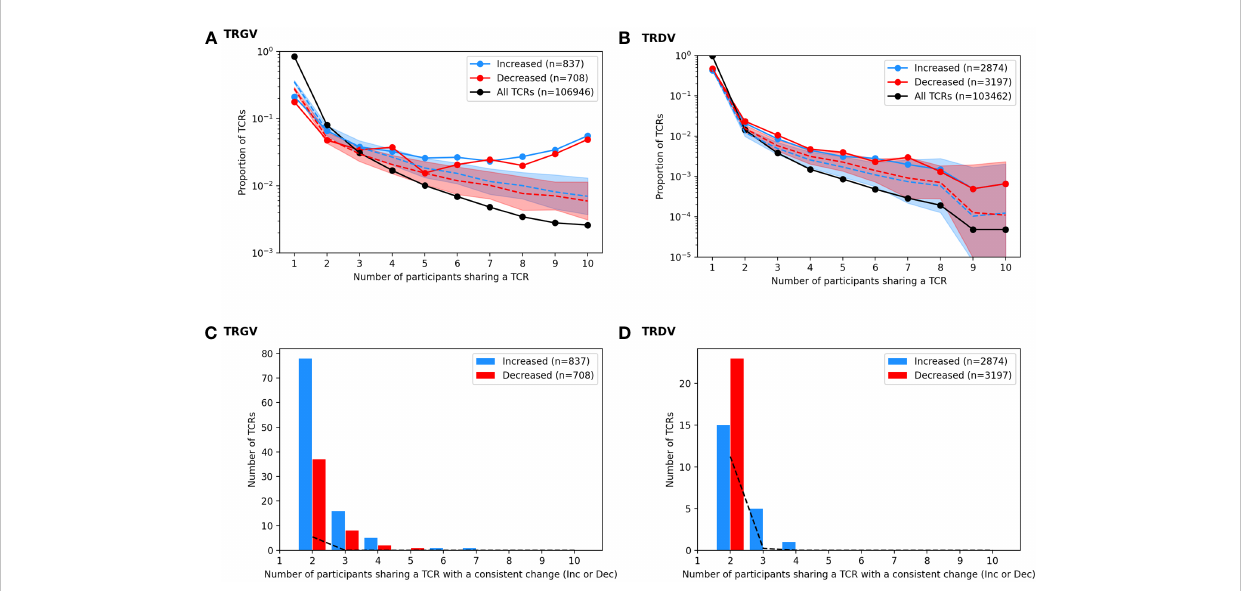
FIGURE 5 Analysis of TCRs with a signi fi cantly different frequency at the pre vs. post BCG time points. TCR g and TCR d repertoires were analyzed to identify TCRs from each participant that either increased or decreased signi fi cantly after BCG vaccination (Fisher ’ s exact test, FDR-adj Q-value < 0.05). (A) A histogram shows the proportion of all unique TCR g chains (black) that were observed in one individual or shared across multiple individuals (x-axis, sharing number). A histogram was also created for the set of TCRs that increased after BCG vaccination (blue, n = 837) and the set of TCRs that decreased after BCG vaccination (red, n = 708). Proportions are represented on a log-scale y-axis. A simulation under the null-hypothesis (i.e., random TCRs were detected as signi fi cantly increased or decreased) was repeated 1000 times, with a histogram computed for each iteration; the median proportion is plotted for the randomly simulated increased (blue dashed line) and decreased (red dashed line) TCRs with a shaded region indicating the 97.5th and 2.5th quantiles. (B) For each TCR that increased signi fi cantly in more than one individual, the number of participants that also showed an increase (blue) in that TCR was tallied; the same analysis was conducted for decreased TCRs (red) yielding a count histogram of the consistency with which each TCR changed after BCG vaccination. Consistency was also quanti fi ed from the null simulated data (black dashed line). (C, D) A parallel set of analyses were conducted based on the TCR-delta chain repertoires.